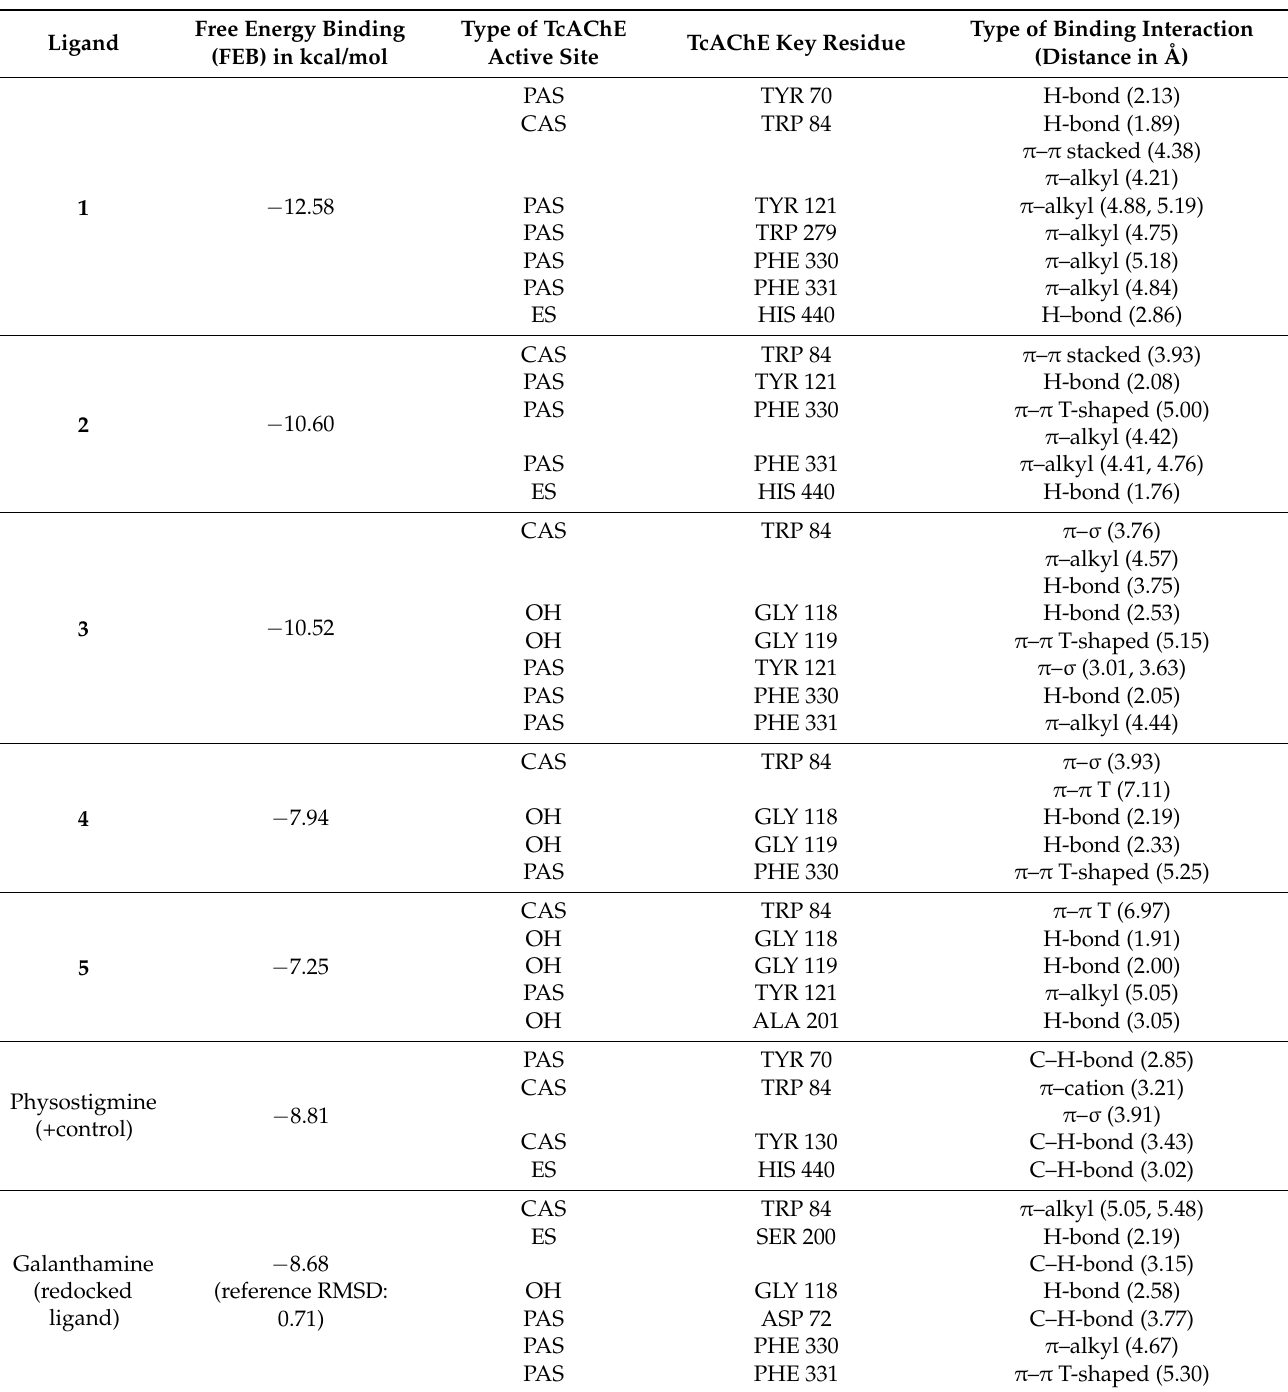
Table 2. Protein–ligand interactions of 1 – 5 with TcAChE (PDB ID: